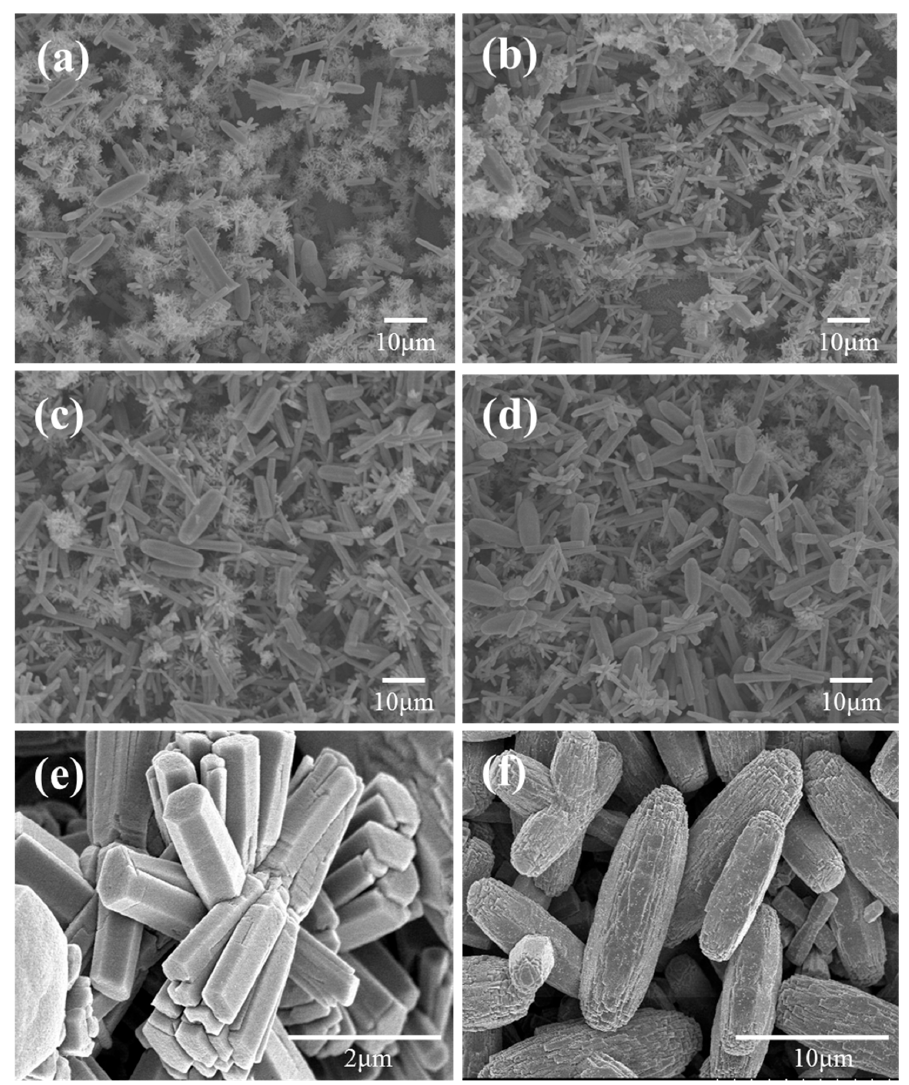
Figure 2. Top-view SEM images of the ZnO layer formed on the FTO glass for ( a ) 4 h, ( b ) 6 h, ( c ) 8 h, and ( d ) 10 h of growth time. Figures ( e , f ) are illustrations of nanoflowers and microrods, respectively.